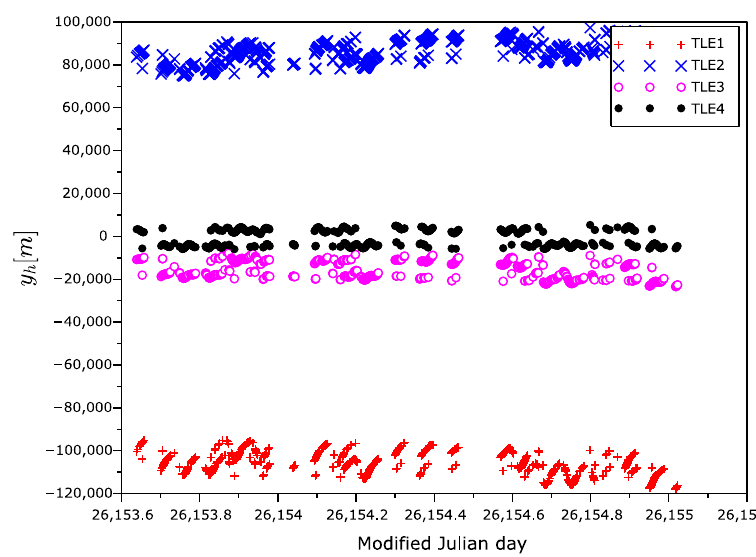
Figure 8. 𝑦 (cid:3035) position error as a function of time in Hill frame.